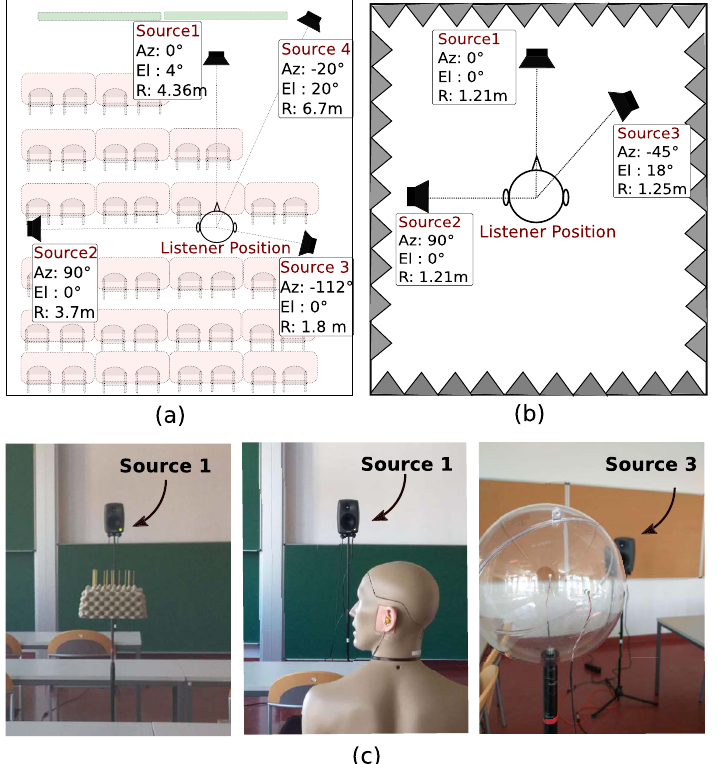
Figure 3. Listener and source positions (Az: azimuth, El: elevation, R: distance to listener) in (a) lecture room (Experiment 1) and (b) anechoic room (Experiment 2). (c): (from left to right) VAH, KEMAR arti fi cial head and the rigid sphere in the lecture